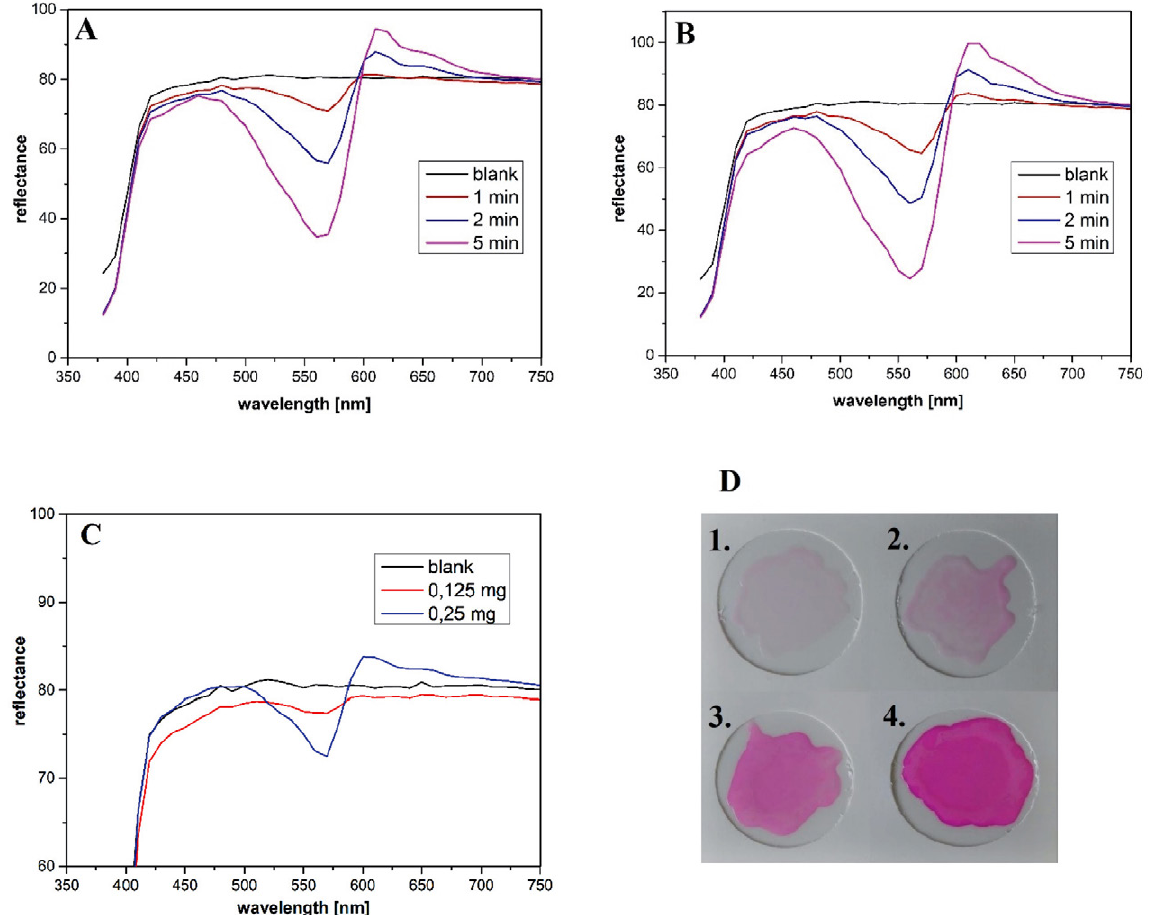
Figure 5: The colouring of the detection film at the diphosgene concentration of 2.2 mg/m 3 (A) and 4.4 mg/m 3 (B) depending on the exposure time is measured. The low concentrations (C) were measured at 10 min exposure time. The colouring examples of the detection film (D) (diphosgene concentration/exposure time) were given at 1) 0.25 mg/m 3 /5 min; 2) 0.5 mg/m 3 /5 min; 3) 2.2 mg/m 3 /2 min; 4) 4.4 mg/m 3 /2 min.